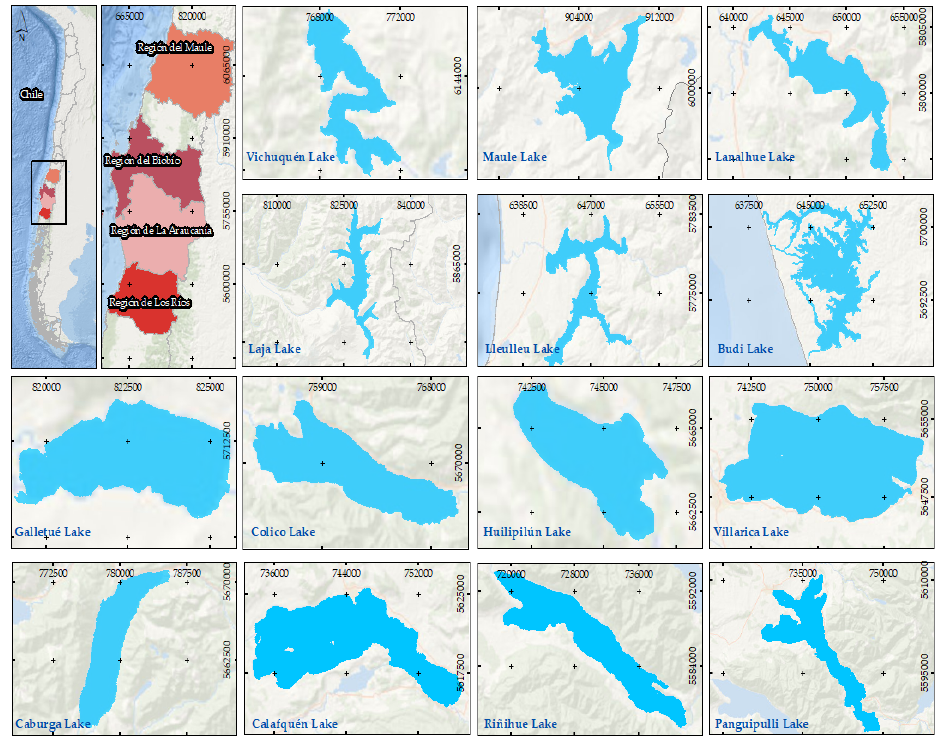
Figure 1. The Maule, Bío-Bío, Araucanía and Los Ríos regions, located in south central Chile and the lakes analyzed in this study.